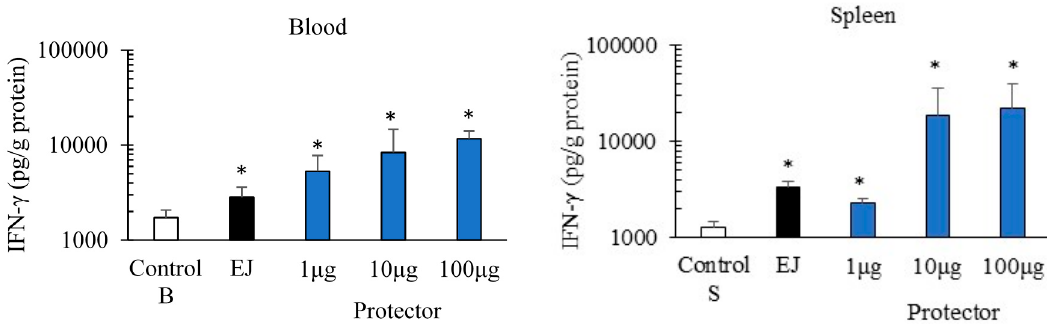
Figure 1. Intraperitoneal administration of “Protector” significantly increased IFN- γ levels in peripheral blood and spleen in dose dependent manner. EJ (10 µg) was used as a positive control. Mice were injected i.p. with “Protector” or EJ and 24 h later, tissues were obtained, processed for cytokines extraction, and then kept frozen until analysis (* indicates p < 0.05 in comparison to control mice).